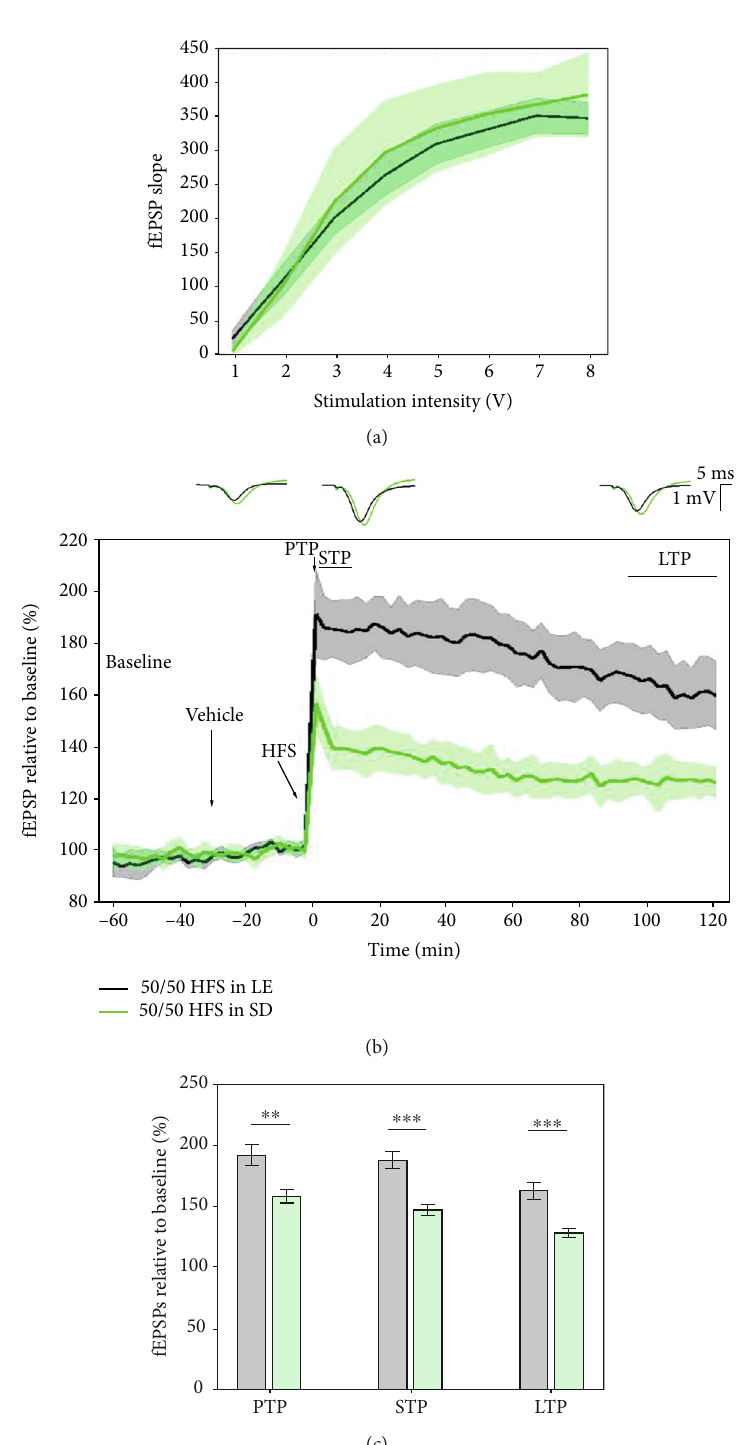
Figure 2: Di ff erential synaptic LTP response to high-frequency stimulation in LE and SD rats. (a) Average input/output curves between stimulation voltage and fEPSP slope show no signi fi cant di ff erence in basal synaptic excitability. (b) LTP responses to the 50/50 HFS protocol in LE rats (black, n = 11 ) were signi fi cantly higher than in SD rats (green, n = 8 ) through the whole 2-hour posttetanisation. Data are presented as means ± 95 % confidence intervals . Outsets above the LTP curve represent average waveform fi eld potentials during 30min baseline prior to tetanisation and 0-30min and 90-120min posttetanisation. Horizontal bar: 1 mV; vertical bar: 5 ms. (c) PTP, STP, and LTP responses are presented as means ± 95 % confidence intervals ; ∗∗ p value < 0 : 01 and ∗∗∗ p value < 0 : 001